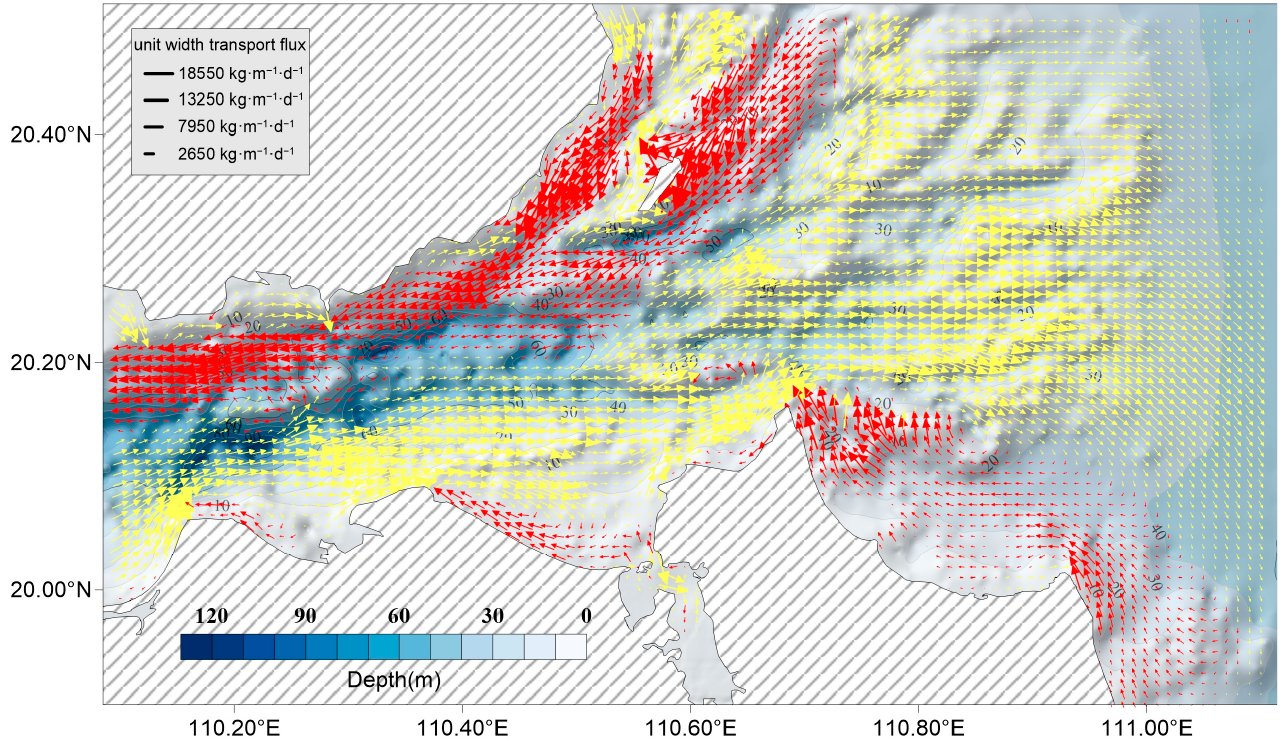
Figure 9. Net bedload transport flux at the east entrance of Qiongzhou Strait during spring tide. The yellow arrow indicates that bedload transport is eastward and the red arrow indicates that bedload transport is westward.